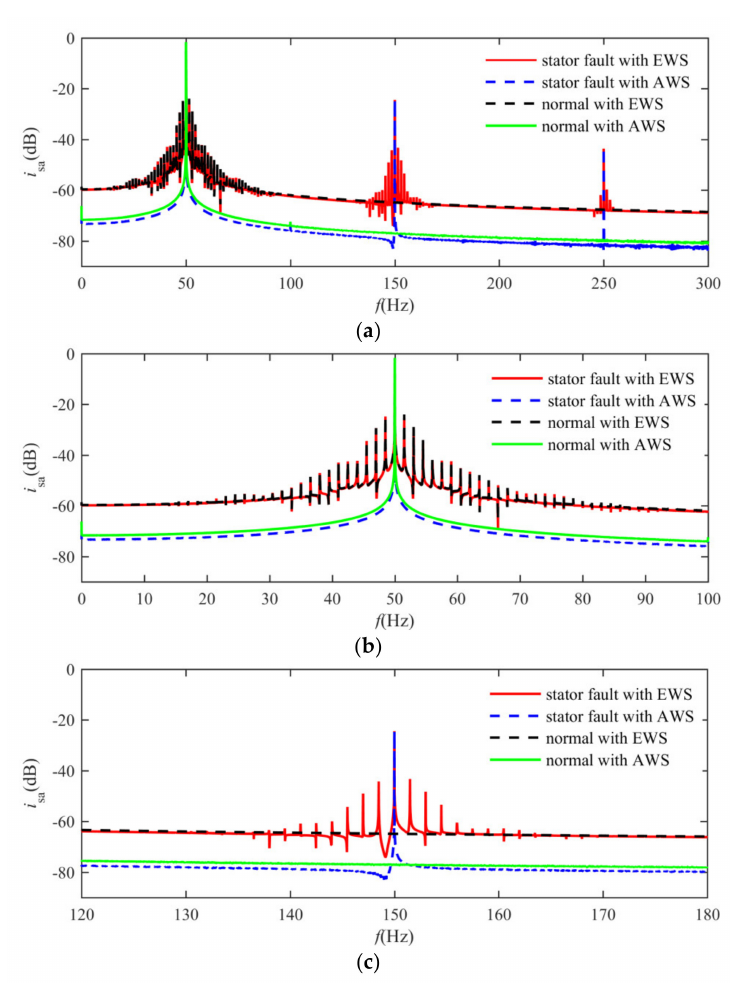
Figure 12. Stator current comparison under the stator winding asymmetry: ( a ) PSD of the stator current from 0 to 300 Hz; ( b ) PSD of the stator current from 0 to 100 Hz; ( c ) PSD of the stator current from 120 to 180